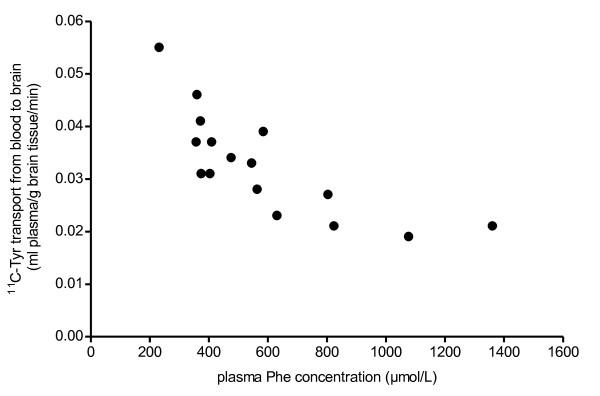
Relation between 11C-Tyr transport from blood to brain and plasma phenylalanine concentration.